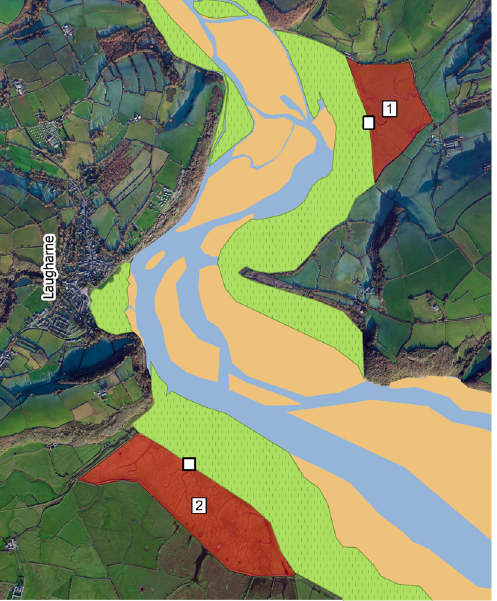
Figure 7. Proposed Taf Estuary managed realignment sites indicated by Cousins et al. [64]. Numbers 1 and 2 indicate Mwche and Mylett farm sites, respectively. White squares indicate suggested breach locations.